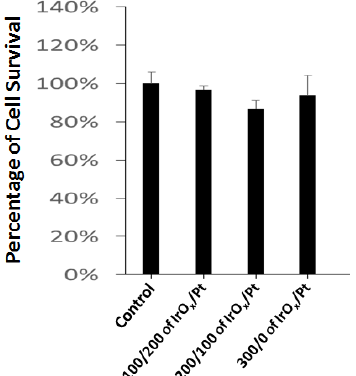
Figure 6. Cell viability percentage of IrO x /Pt composite films.